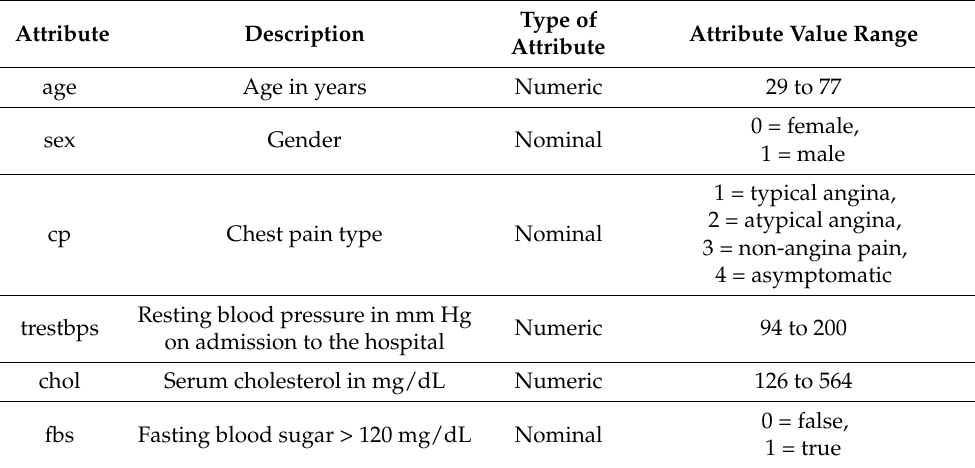
Table 1. Attribute descriptions for the Cleveland heart dataset from the UCI machine learning repository [33].